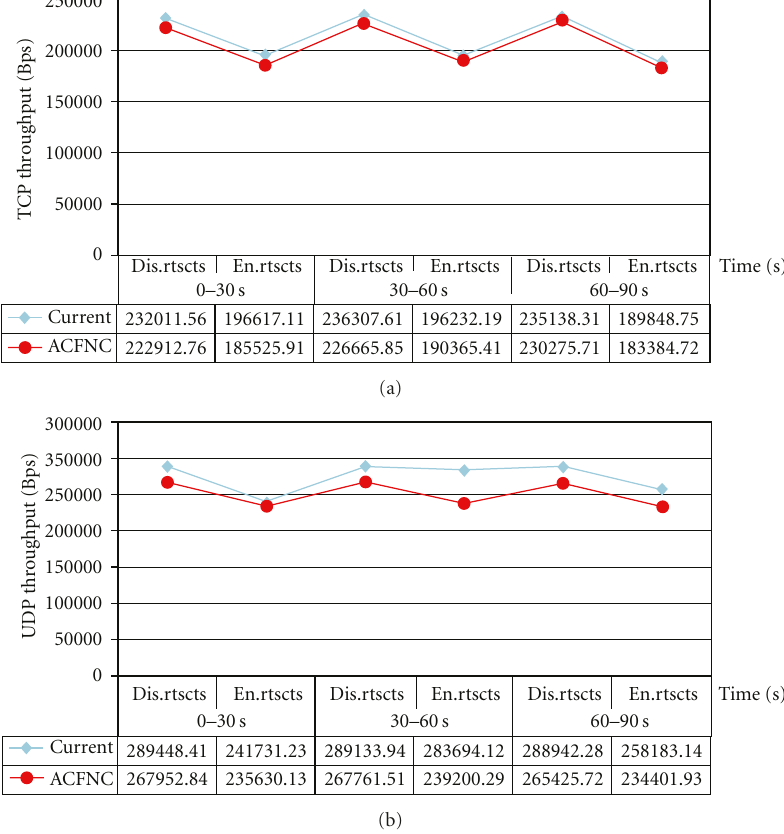
Figure 10: (a) TCP, (b) UDP throughput comparison in baseline mode.